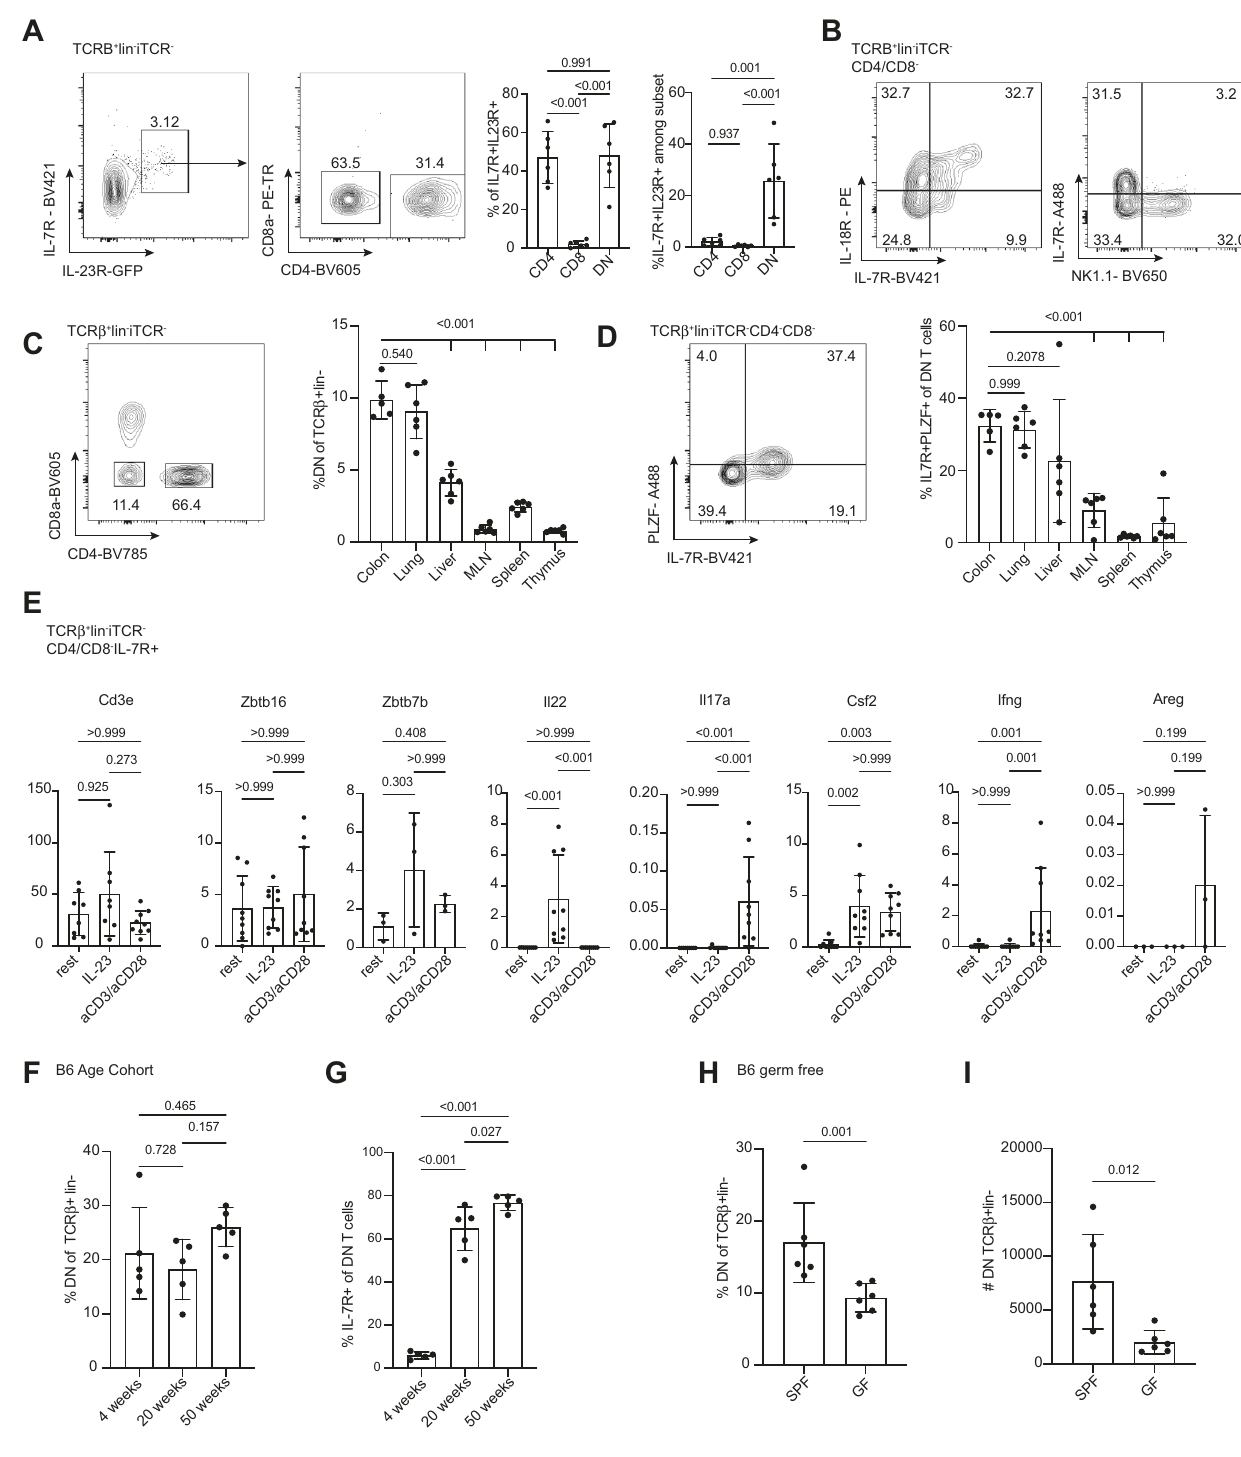
MHC-II restricted cytokine and microbe-reactive T cells in mice are CD4/CD8